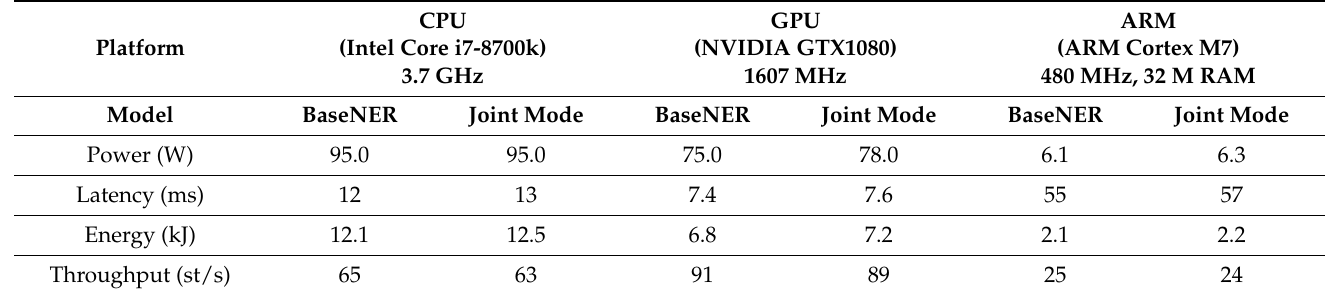
Table 9. Performance comparison between different platforms. st/s is used for the throughput metric, which is the number of sentences inferred per second.